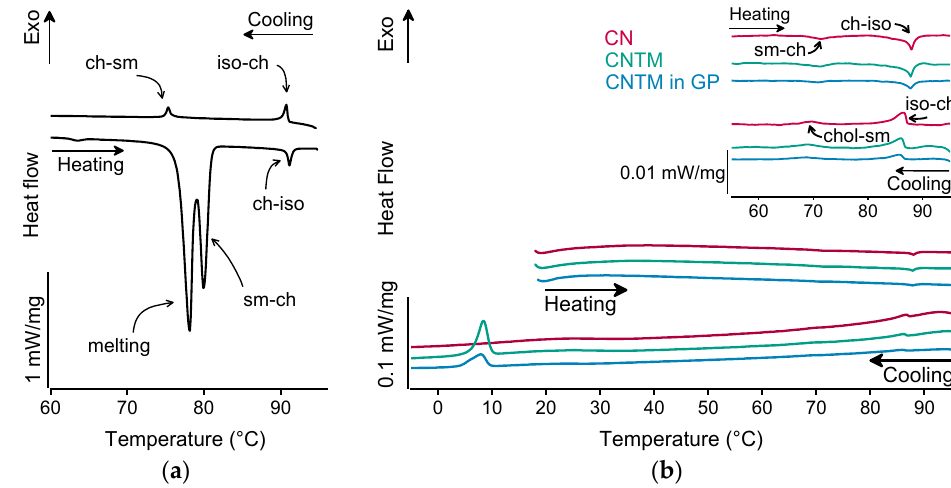
Figure 2. DSC curves of ( a ) cholesteryl nonanoate bulk material, ( b ) nanodispersions of pure cholesteryl nonanoate (CN), mixed cholesteryl nonanoate and trimyristin (CNTM), and the CNTM dispersion incorporated in hydrogel particles (CNTM in GP). The insert shows the transitions in the upper temperature range at a higher magnification. Further abbreviations: sm—smectic, ch—cholesteric, iso—isotropic melt. Scan rate: 5